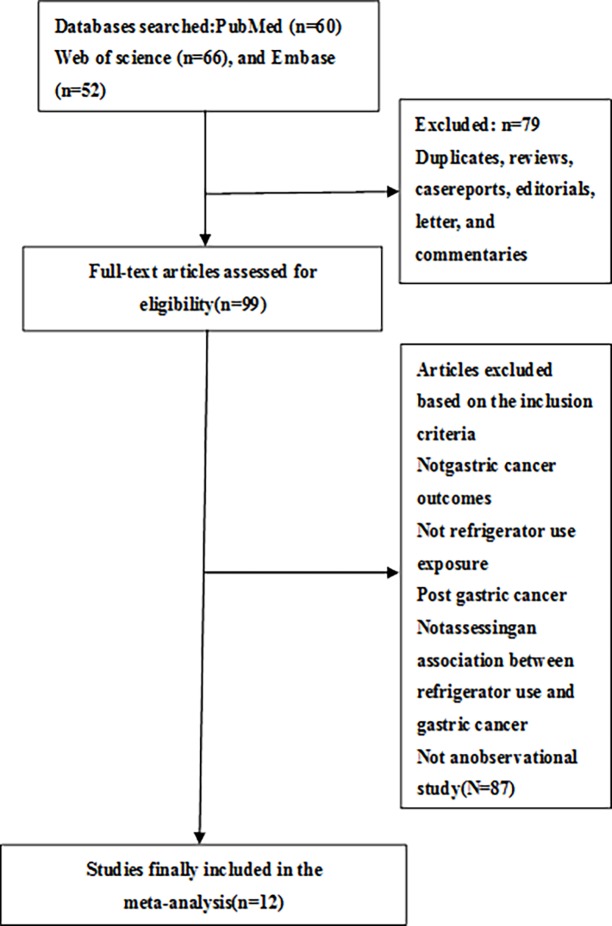
Study selection process for the Meta-analysis.